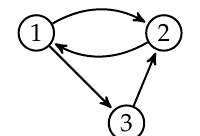
∨ x (cid:48) ) , x ∨ x ) 3 1 3 1